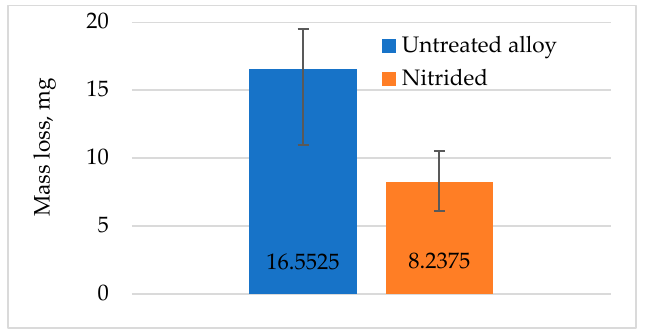
Figure 7. Wear loss of tested specimens.